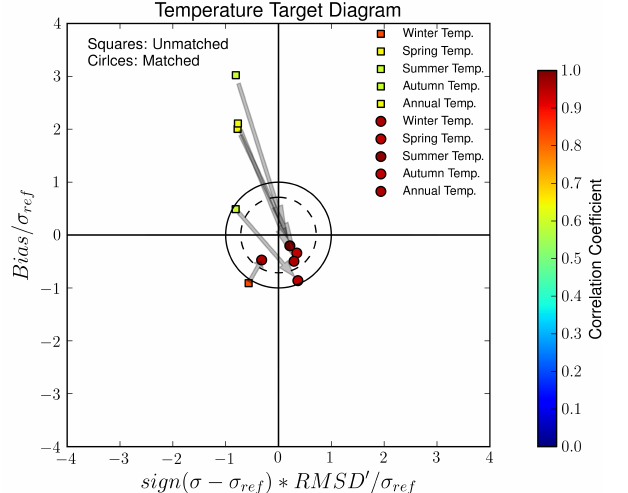
Fig. 20. Target diagram showing the impact of the transition from Fig.20. Targetdiagramshowingtheimpactofthetransitionfromtheunmatchedtothematchedmethods on salinity. the unmatched to the matched methods on salinity.